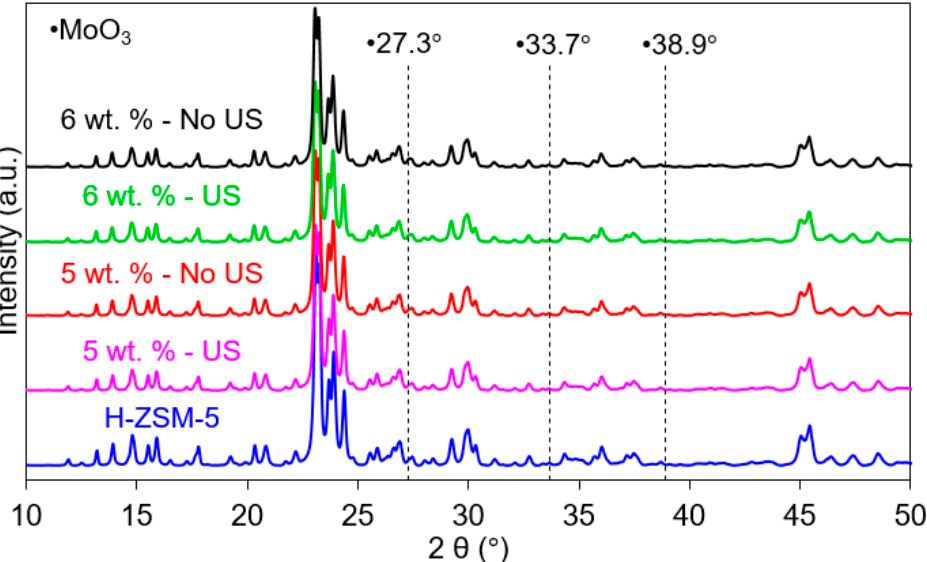
Figure 1. XRD patterns of H-ZSM-5 and Mo/ZSM-5 catalysts prepared by ion-exchange with ultrasound (US) and without ultrasound (No US).